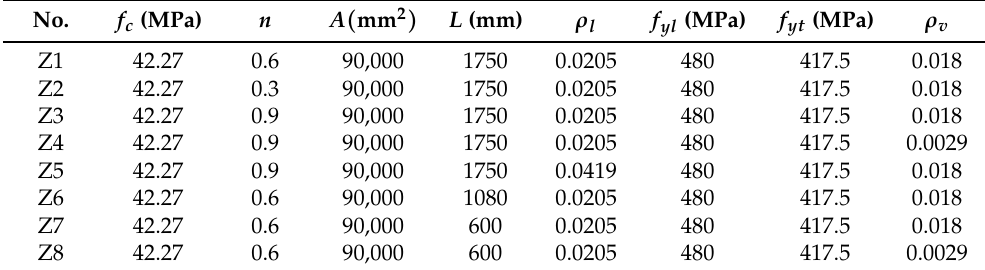
Table 8. Design parameters of eight RC columns.